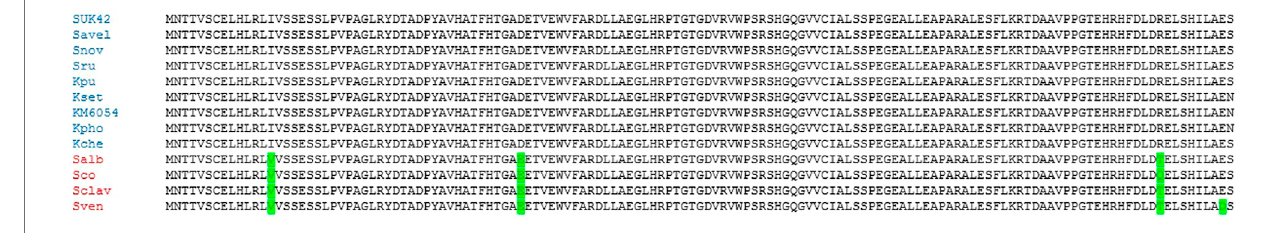
FIGURE 3 | Alignment of SsgB sequences from Kitasatospora sp. SUK42, other putative Kitasatospora reference sequences and model strains from the genus Streptomyces . SsgB sequences were aligned using Clustal Omega in Mega (Kumar et al., 2018). Amino acid substitutions in model strains of S treptomyces are highlighted in green.